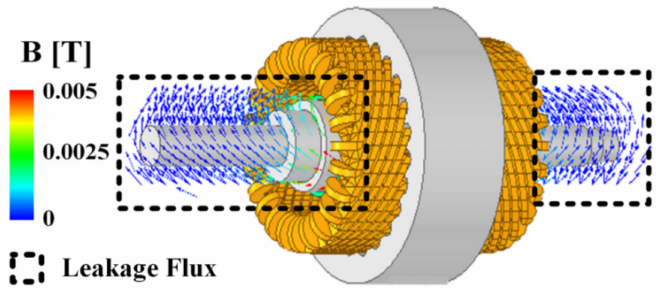
Figure 6. Leakage magnetic flux of Inconel 718 shaft